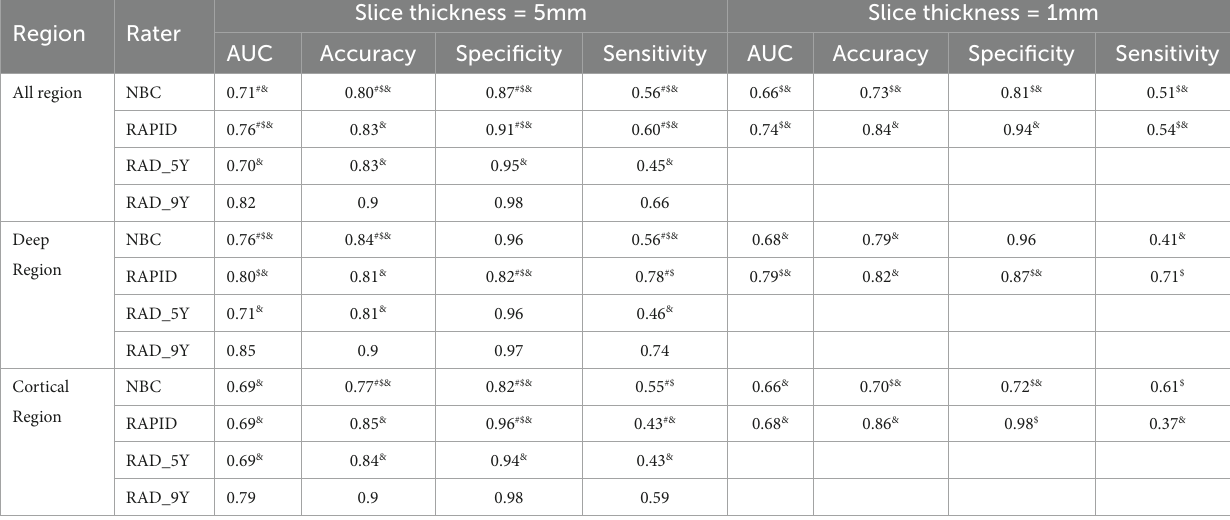
TABLE 3 Sensitivity, specificity, accuracy and AUCs of region-based analysis of ASPECTS.